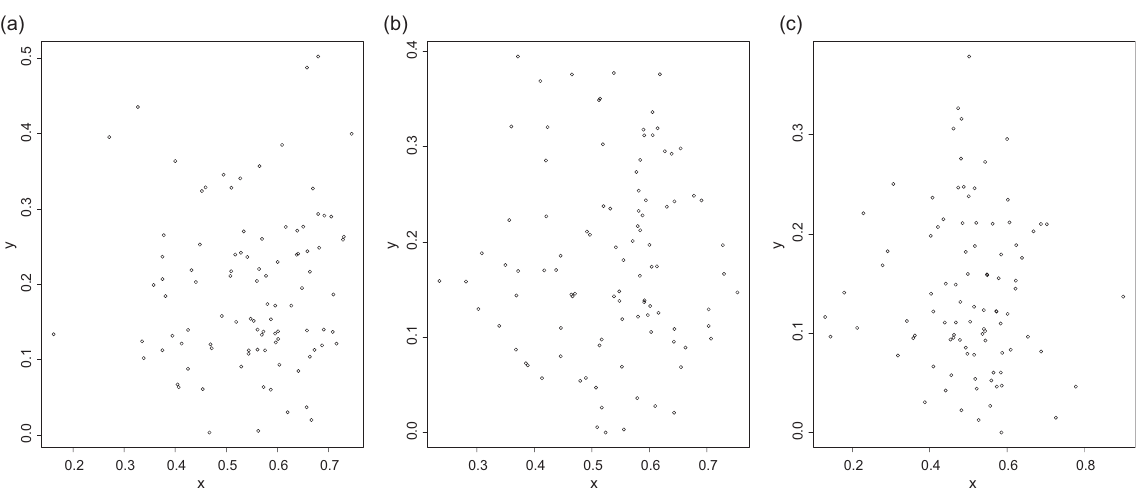
Figure 3. Plot between X (horizontal axis) and Y (vertical axis). (a) Year 2013, (b) year 2014, (c) year